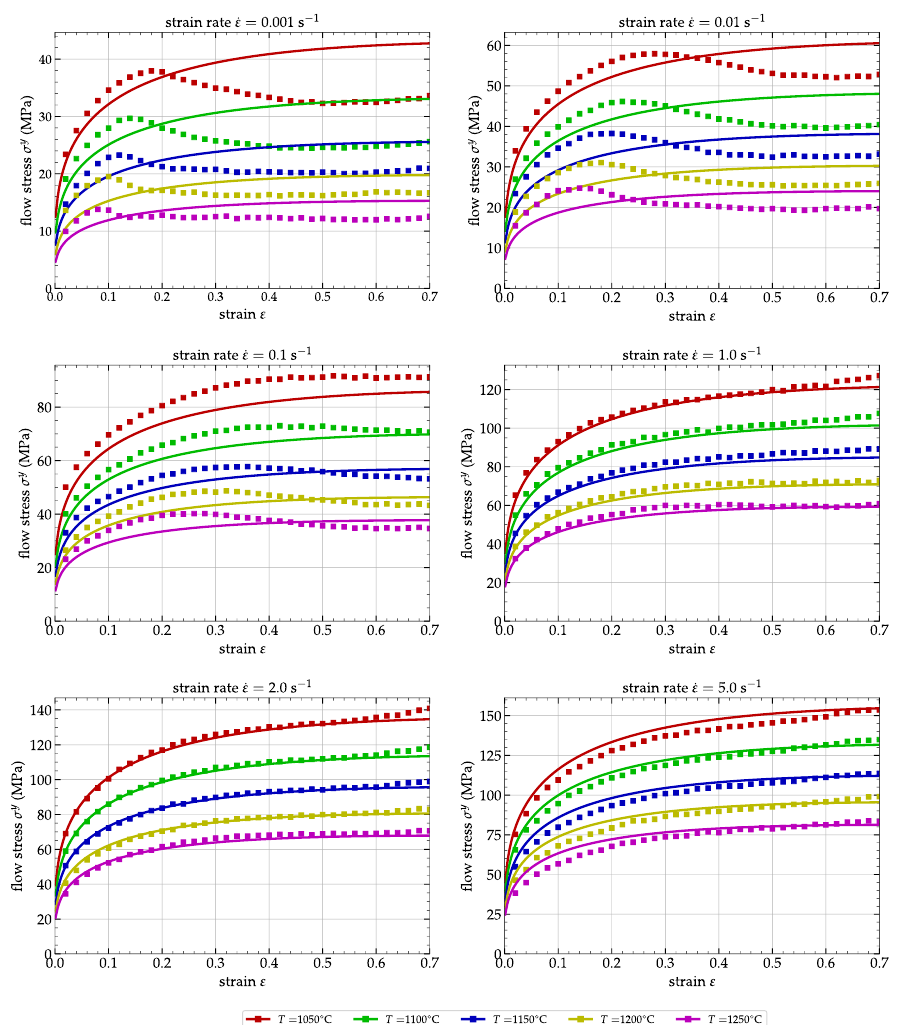
Figure 8. Comparison between the experimental (dots) and predicted (lines) flow stresses σ y by the Hansel–Spittel